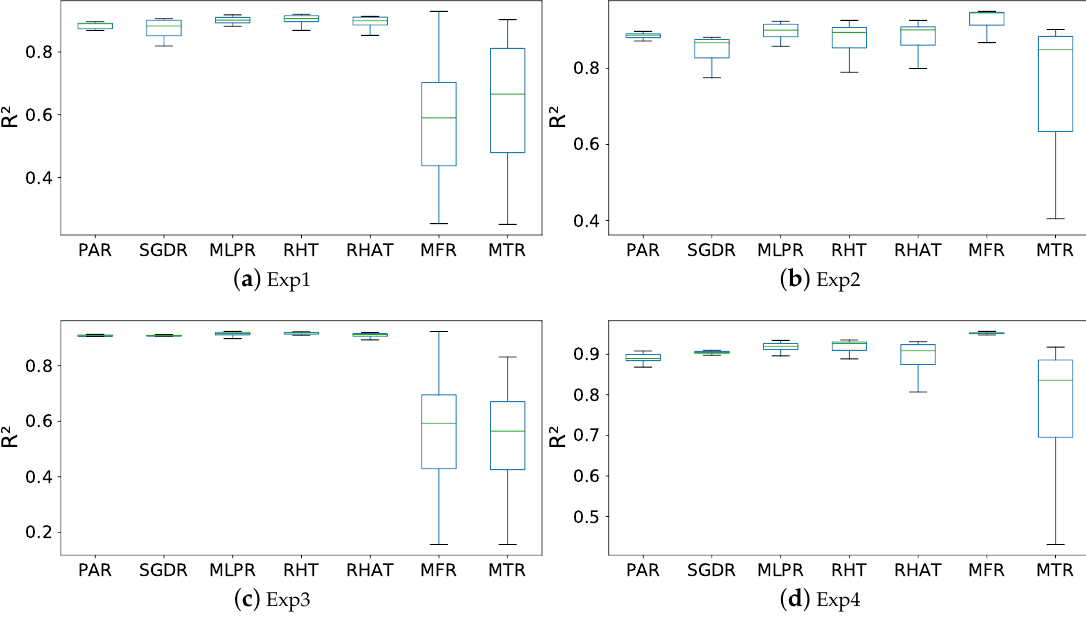
Figure 10. Boxplots of ANOVA tests for R 2 in each